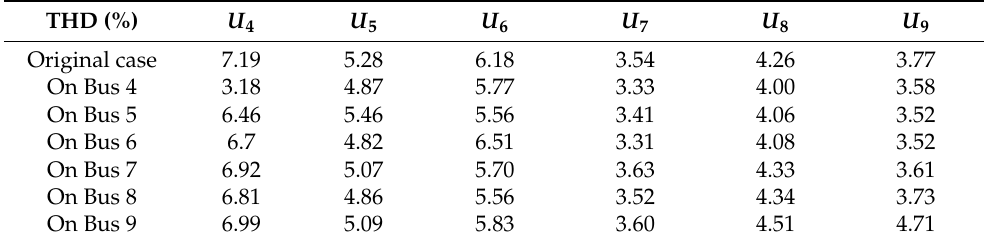
Figure 18. Voltage distortion when inverters are connected at different nodes. Table 3. The THD information when three inverters were connected at different buses.